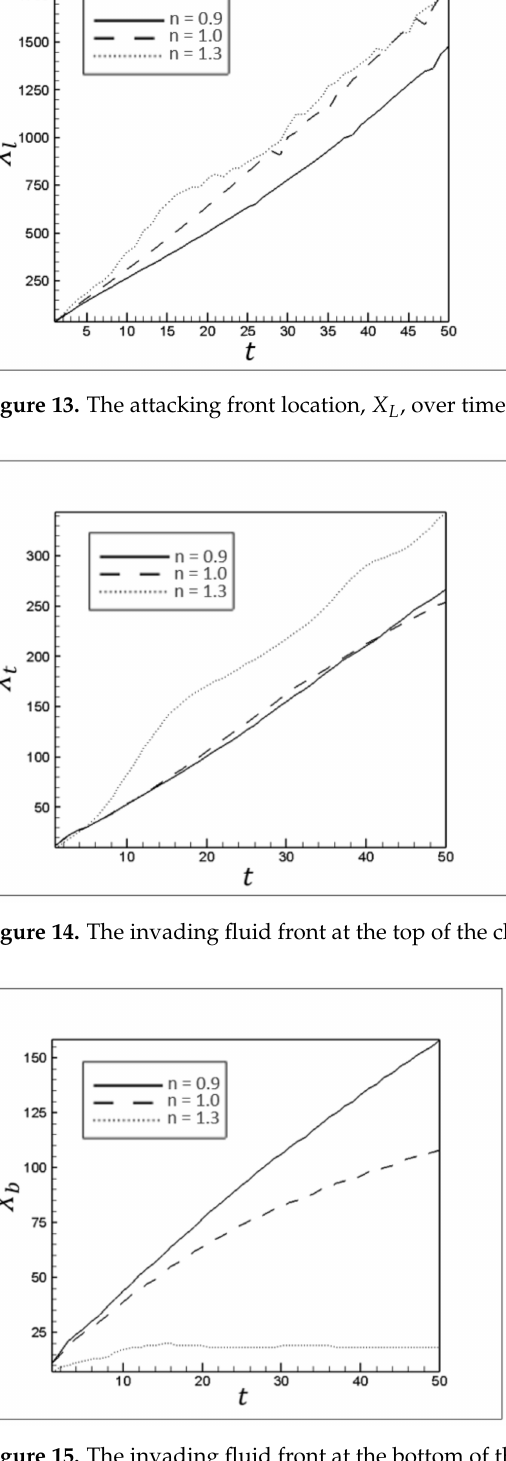
Figure 15. The invading fluid front at the bottom of the channel, X b , over time for different n. Figures 16 and 17 show the thickness of the static layers at the top and bottom of the channel, H t and H b , respectively. Since the buoyancy force is a function of the Atwood number, the injected fluid initially experiences the same driving force toward the top wall of the channel for all the cases. Nevertheless, due to the lower viscosity of the displaced fluid with n = 1.3, a smaller viscous force restricts the upward movement of the injected